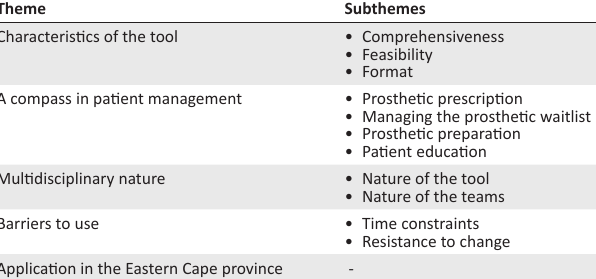
TABLE 3: Themes and subthemes identified from the